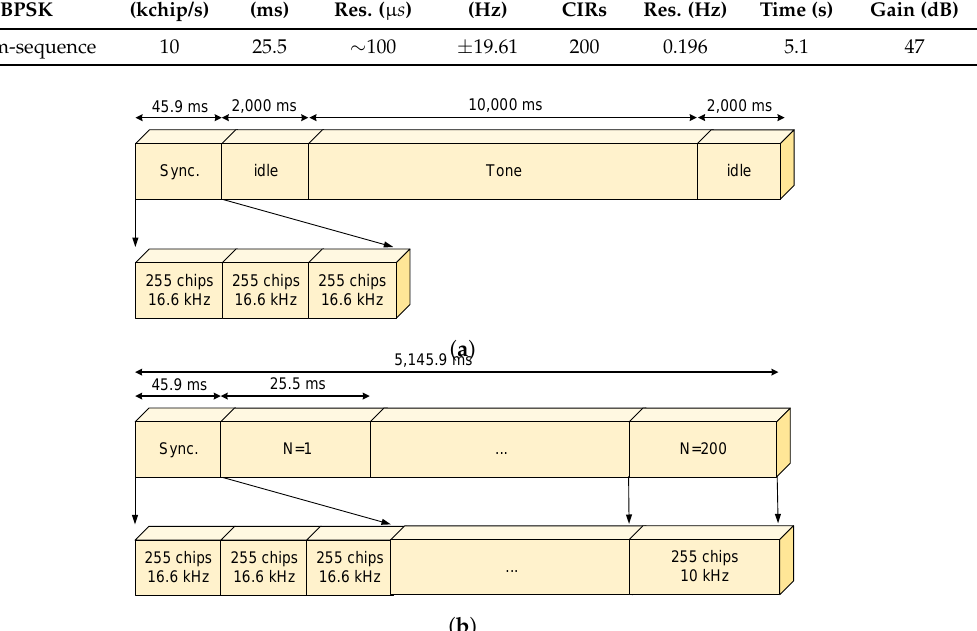
Table 4. Characteristics of the wideband sounding waveform of the Antarctica project Waveform Chip-rate